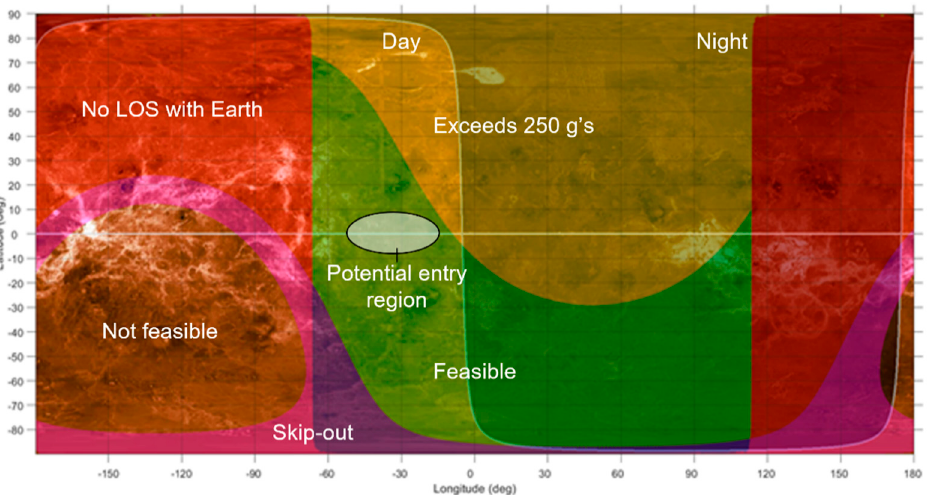
Figure 3. Entry location accessibility map for the 2026 trajectory. Green: Feasible entry region with a line of sight with Earth; Red: No line of sight with Earth; Yellow: Deceleration load greater than 250 Earth g; Pink/Purple: Probe skips out of the atmosphere. The probe enters near the equator within the region marked by the oval.